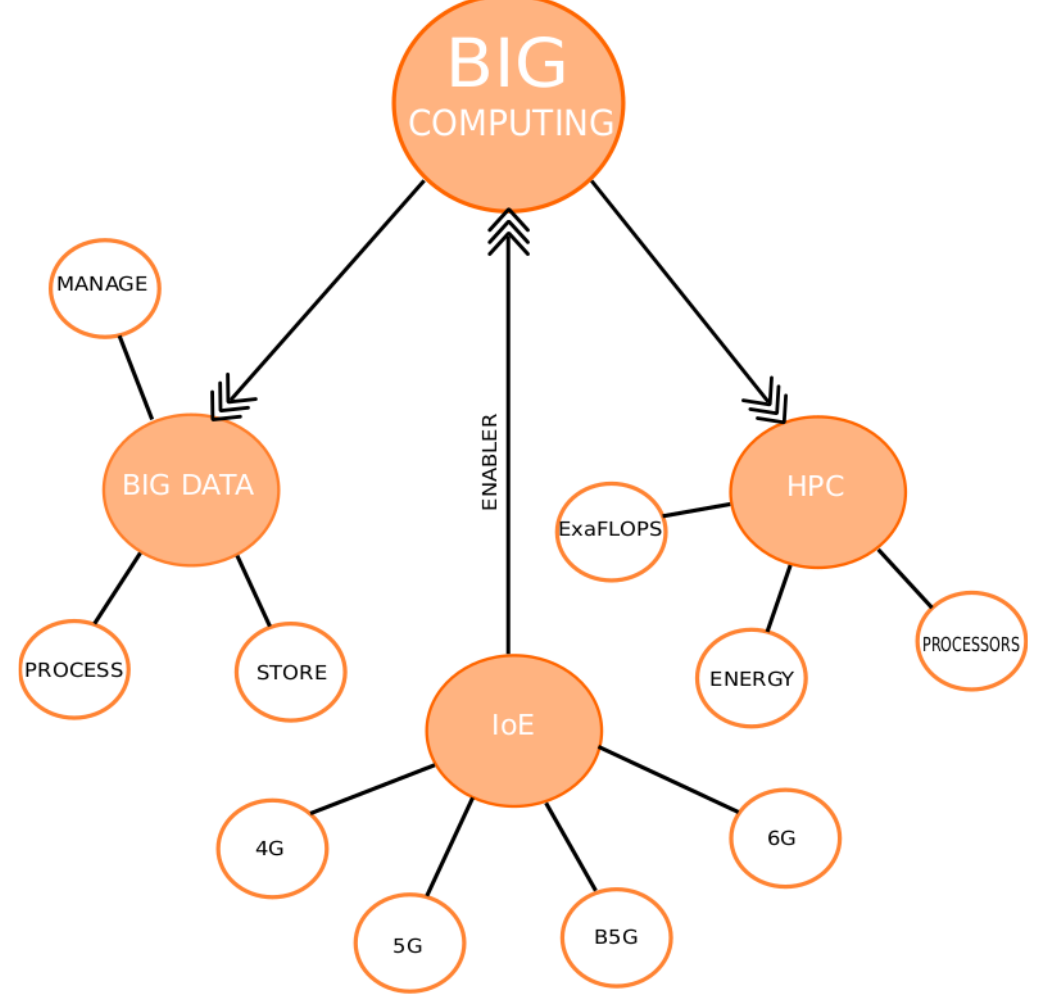
Figure 1. Big Computing and its enabling